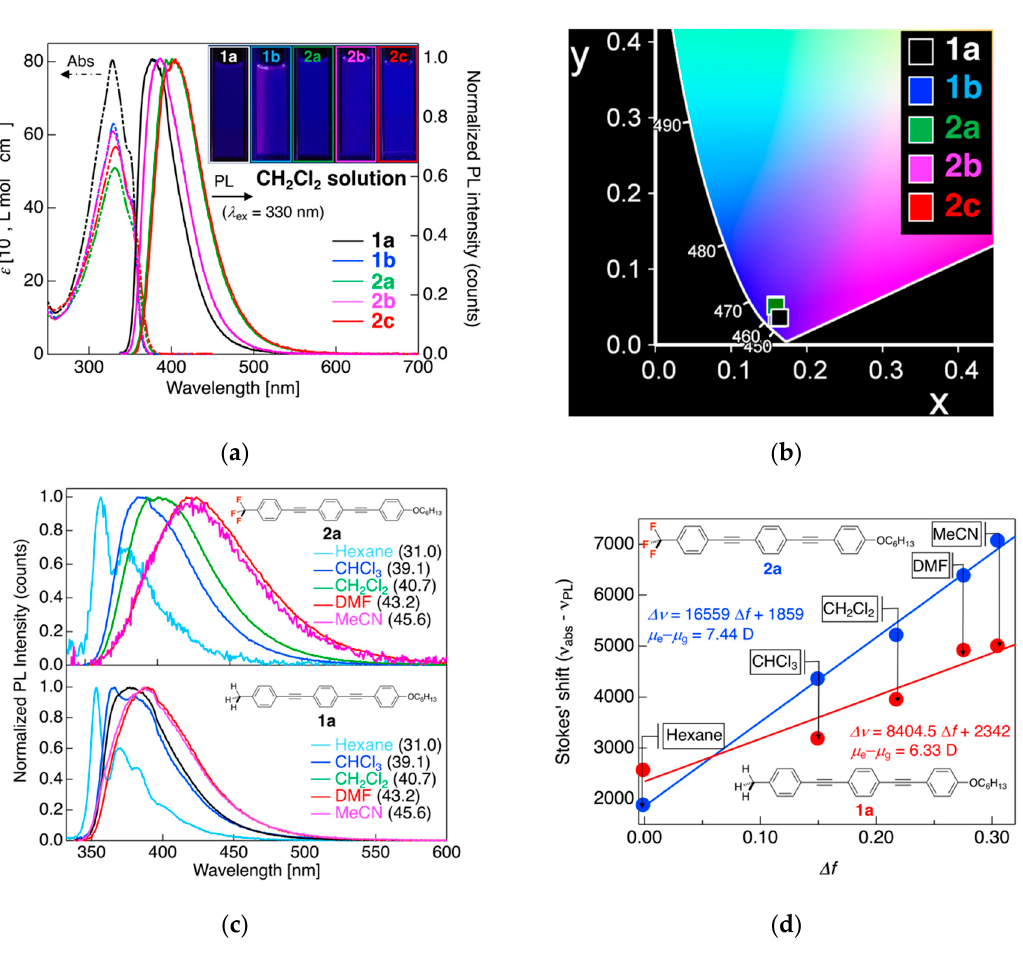
Figure 6. ( a ) UV–Vis and PL spectra of 1a , 1b , and 2a – 2c measured in CH 2 Cl 2 (inset: photographic images of the PL observed under UV irradiation at λ ex = 365 nm); ( b ) Commission Internationale de l’Eclailage (CIE) diagram indicating the PL color; ( c ) PL spectra of 1a and 2a in various solvents. The values in parentheses indicate the E T (30) values, which are quantitative indicators of the solvent polarity; ( d ) Lippert–Mataga plot calculated from the Stokes’ shift ( Δ ν = ν abs − ν PL ) and a solvent polarity parameter ( Δ f ). Table 2. Photophysical data for 1a , 1b , and 2a – 2c recorded in various solvents 1 . Compound